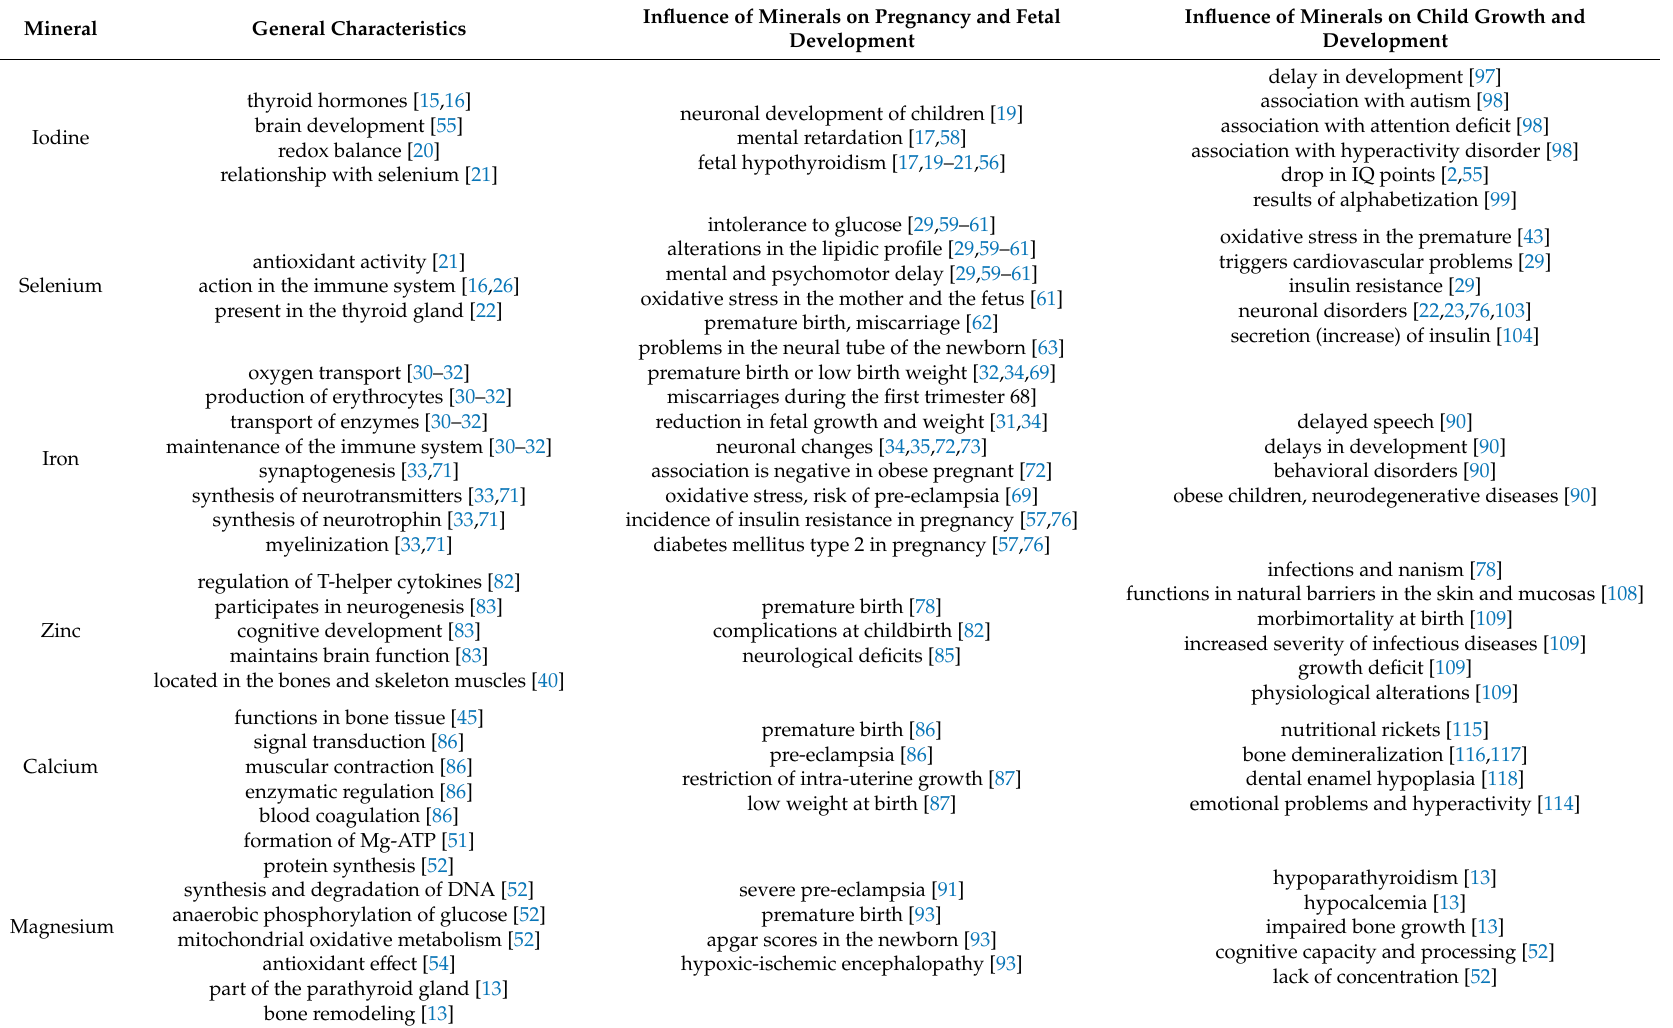
Table 1. General characteristics, influence of minerals on pregnancy and fetal development, and influence of minerals on child growth and